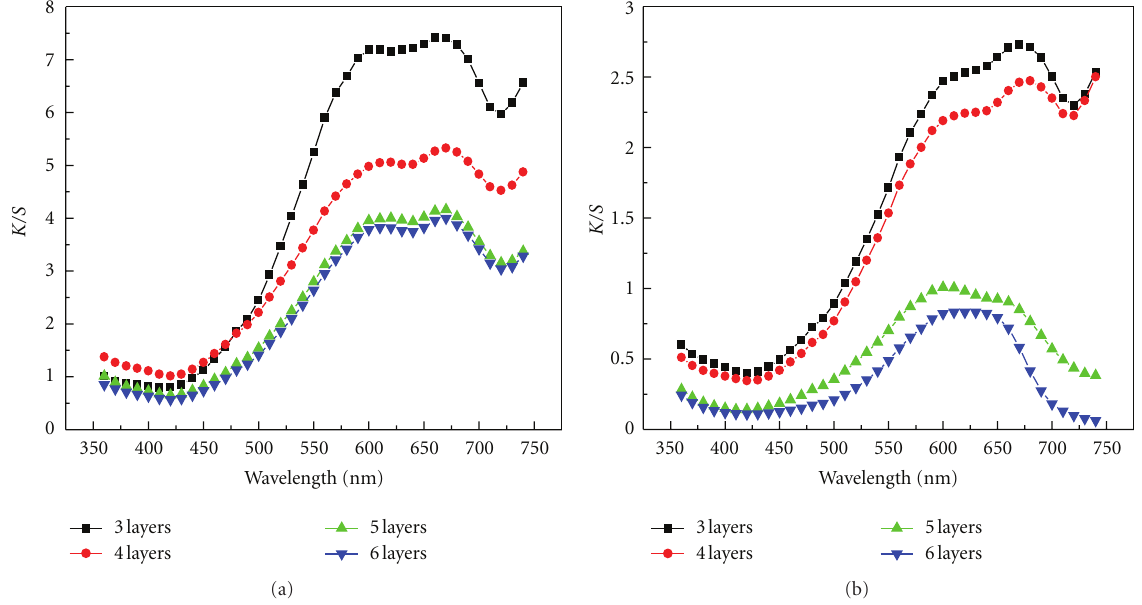
Figure 8: K/S curves of the membranes coated with di ff erent layers before (a) and after (b) photocatalytic process: the substrate is PAN composite nanofibrous membranes with